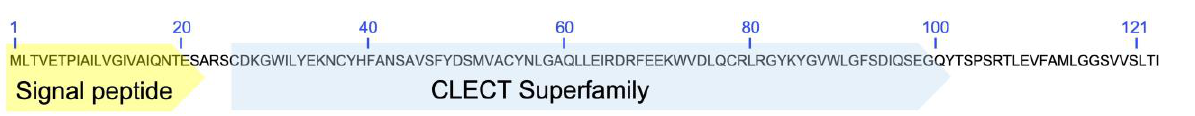
Figure 8. Protein sequence of the perlucin ( LOC111110737 ). Signal peptide is in yellow and C-lectin domain is in blue. The length and number of amino acids are shown.